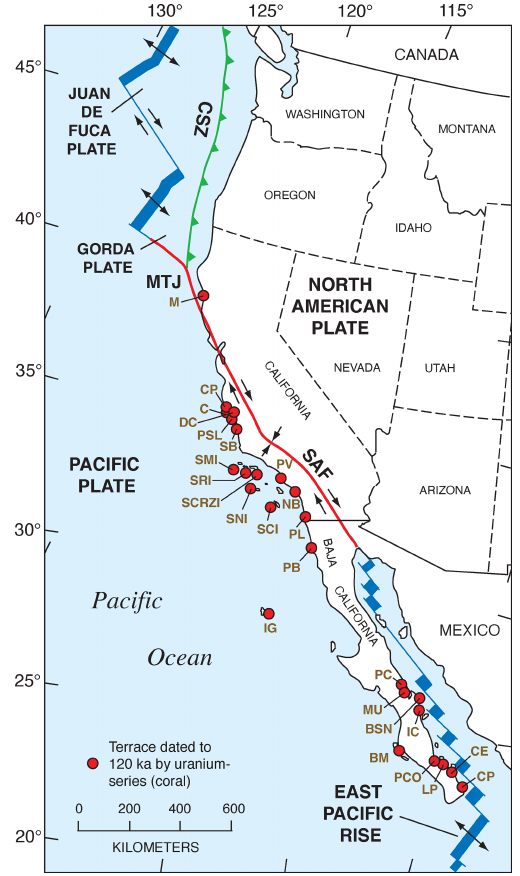
Figure 14. Map of the Pacific coast of North America with struc- tural features as shown in Fig. 2, but also plotted are localities (filled red circles) where U-series ages of corals dating to MIS 5e ( ∼ 120ka) have been reported. Structural features are redrawn in simplified form from Drummond (1981) and Simkin et al.